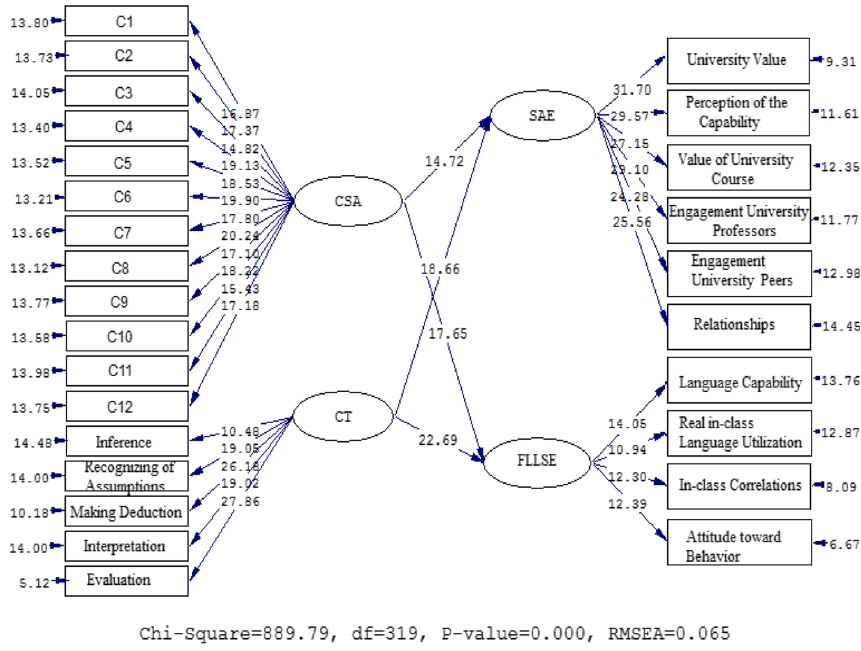
Fig. 3 T values for path coefficient significance (model 1)